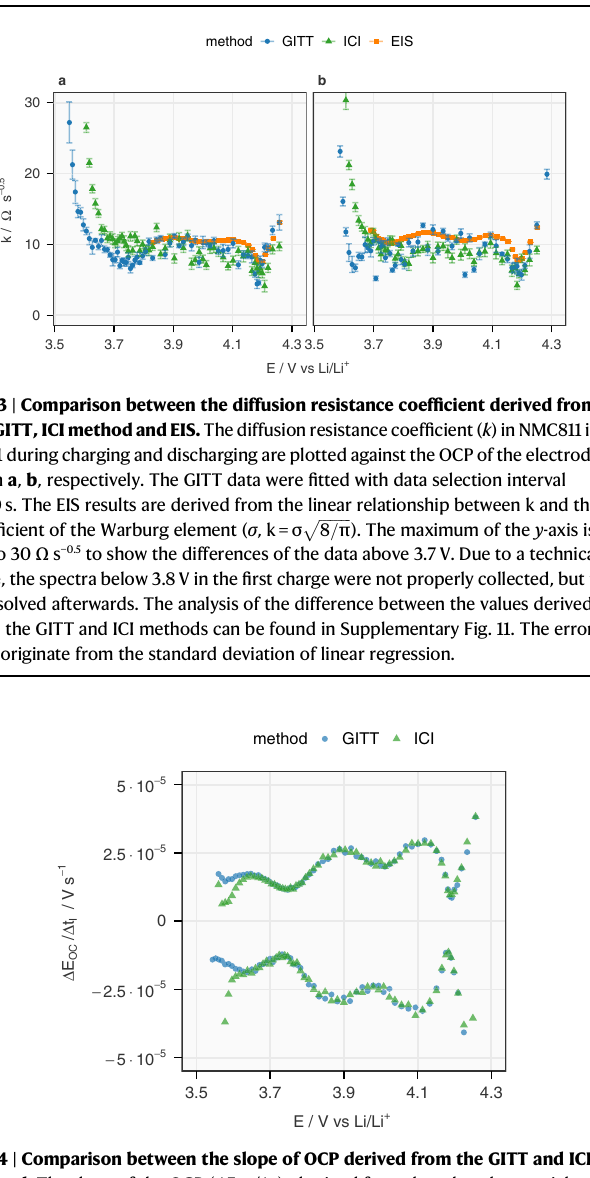
Fig. 4 | Comparison between the slope of OCP derived from the GITT and ICI method. The slope of the OCP ( Δ E OC / Δ t I ) obtained from the relaxed potentials at theendofeachrestperiod(GITT)iscomparedwiththeslopeofthepotentialunder constant-current load subtracting the iR-drop derived from the ICI method ( Δ [ E( Δ t = 0)]/ Δ t I , marked as ICI). The values are obtained from Cell 1 in the fi rst cyclesandthepositiveandnegativeduringcharginganddischarging,respectively. The analysis of the difference between the values derived from the GITT and ICI methods can be found in Supplementary Fig. 12.